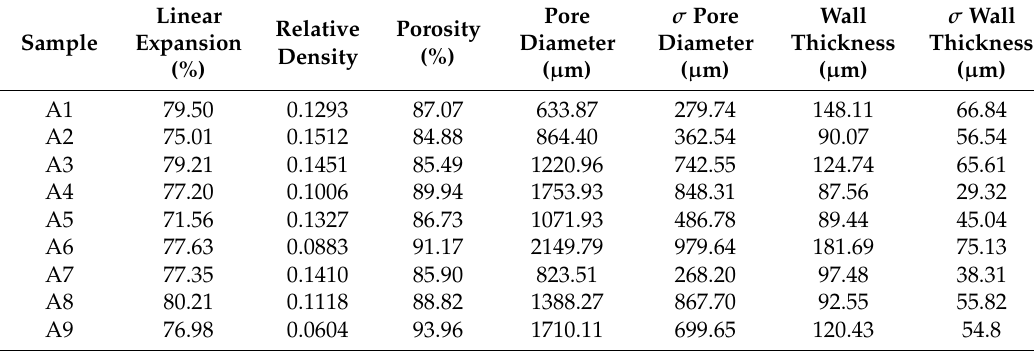
Table 5. Linear expansion, relative density, porosity, pore diameter and wall thickness of the indicated A-242 aluminium alloy foams ( σ = standard